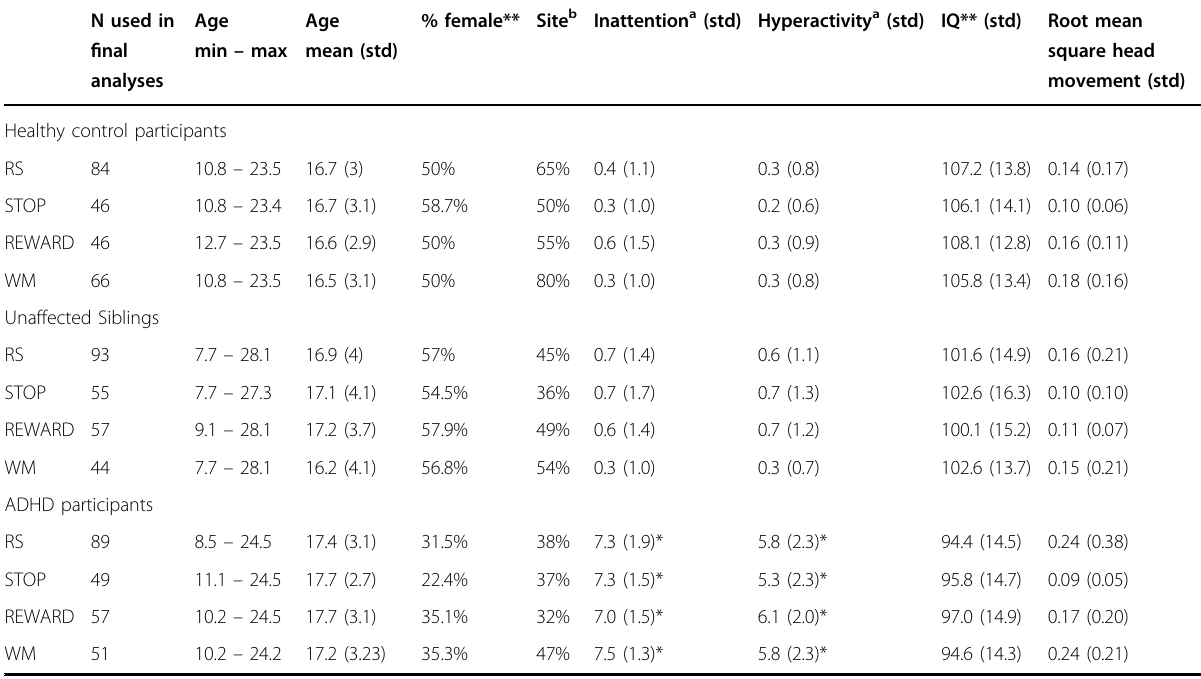
Table 1 Participant information: descriptive, clinical variables, head movement during scanning and distribution of scan modalities, for each group sample and tasks: resting state (RS), stop signal paradigm (STOP), reward processing (REWARD), working memory